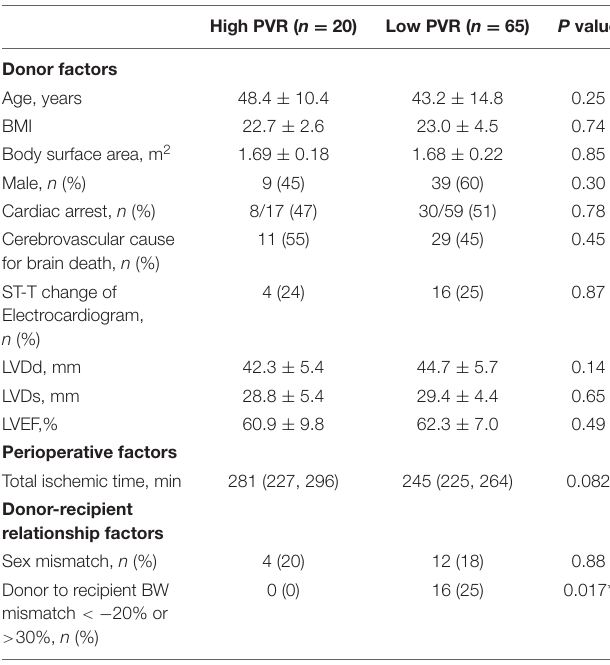
TABLE 2 | Baseline demographic and clinical parameters of donors, clinical course after HTx and donor-recipient relationship factors in two groups.